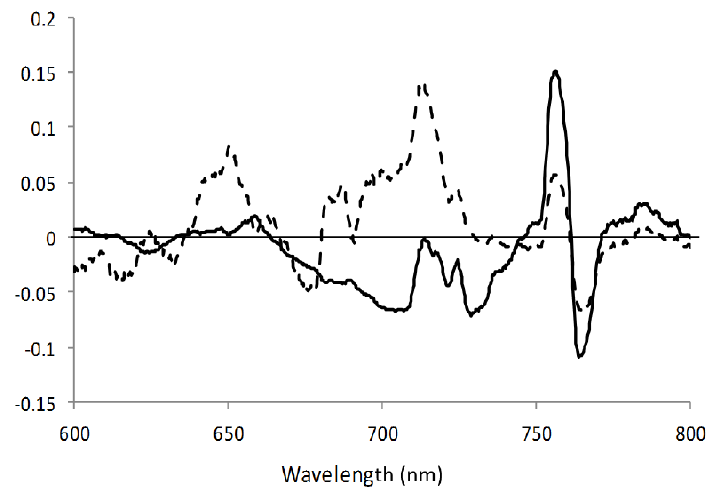
Figure 4. Loadings plot for principal component model developed using all 270 samples over the five test days in the range of 600 to 800 nm. PC1 (——) and PC2 (— —) explain 69% and 24% of the variation in the model, respectively.